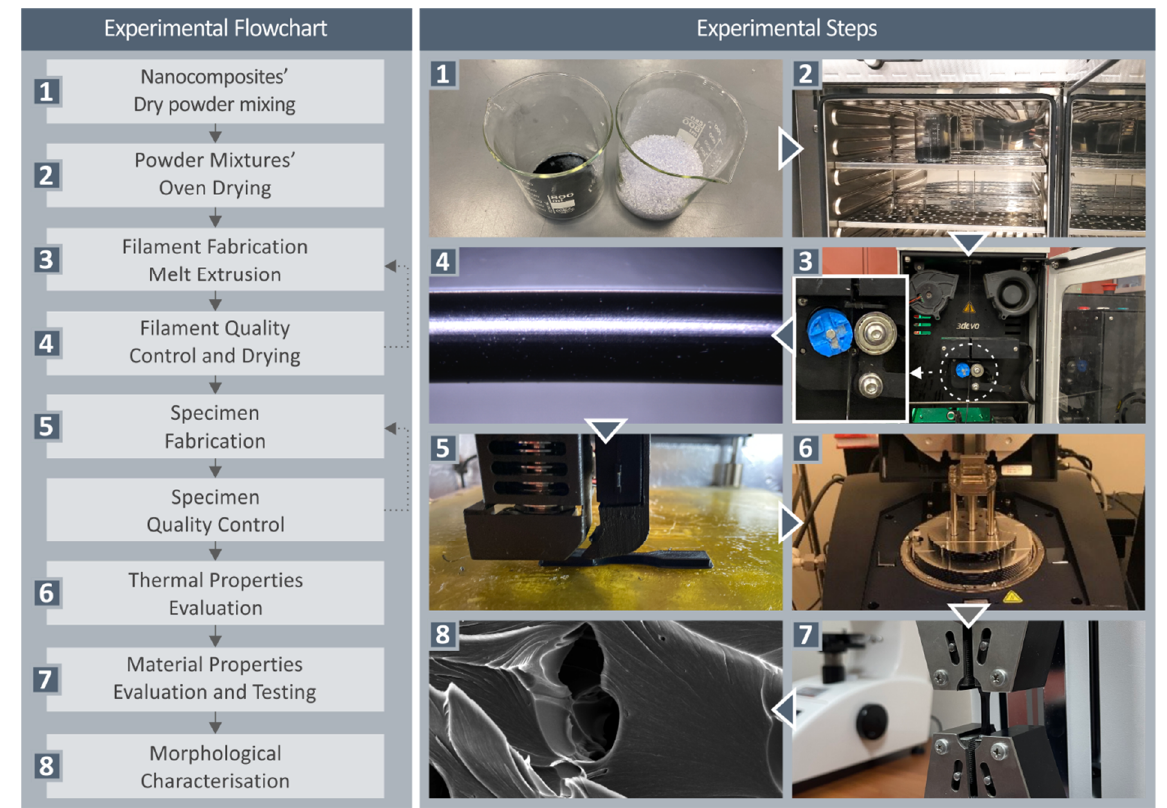
Figure 1. Workflow followed in the current